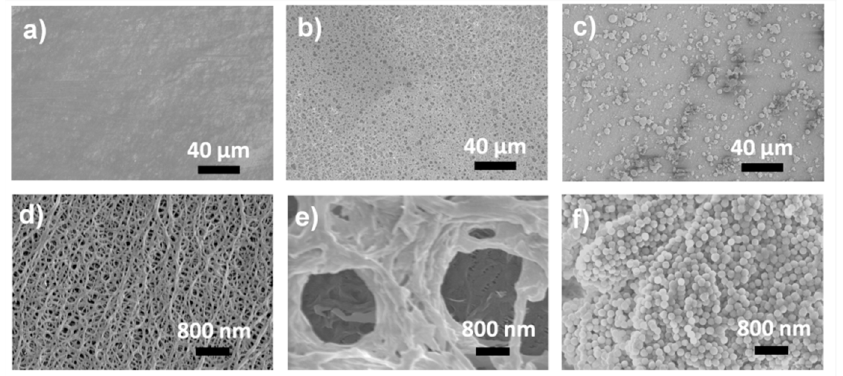
Figure 1. Schematic showing the synthesis of the PIC separator.